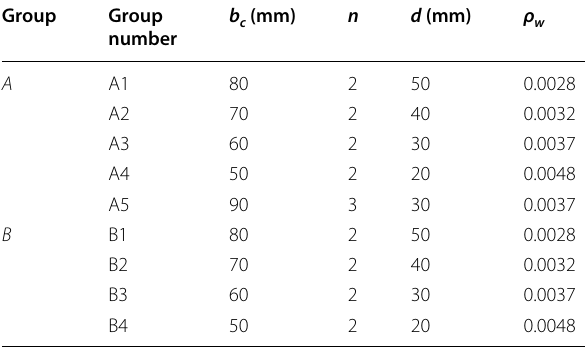
Table 1 Parameters of HSSSWR-reinforced ECC specimens.